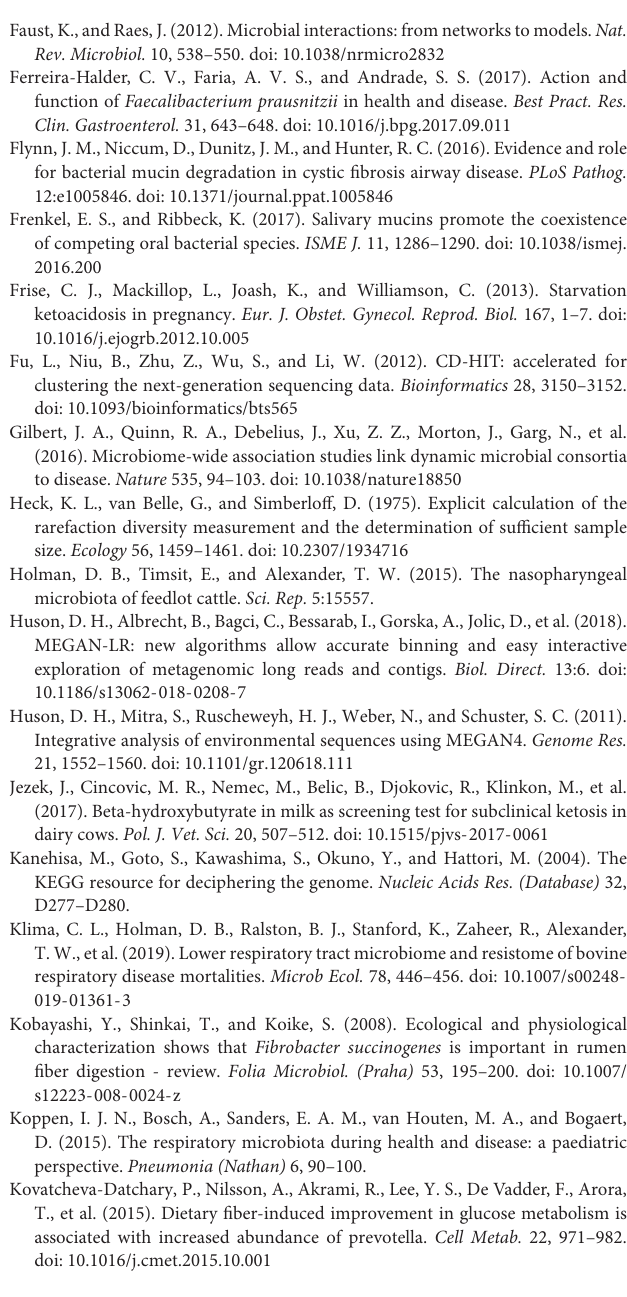
Supplementary Table 2 | Detailed relative abundance of KOs of each sample. Supplementary Table 3 | Detailed relative abundance of all KEGG third-level pathways of each sample. Supplementary Table 4 | Detailed relative abundance of every species of each sample. Supplementary Table 5 | Detailed relative abundance data at the phyla level of each sample.